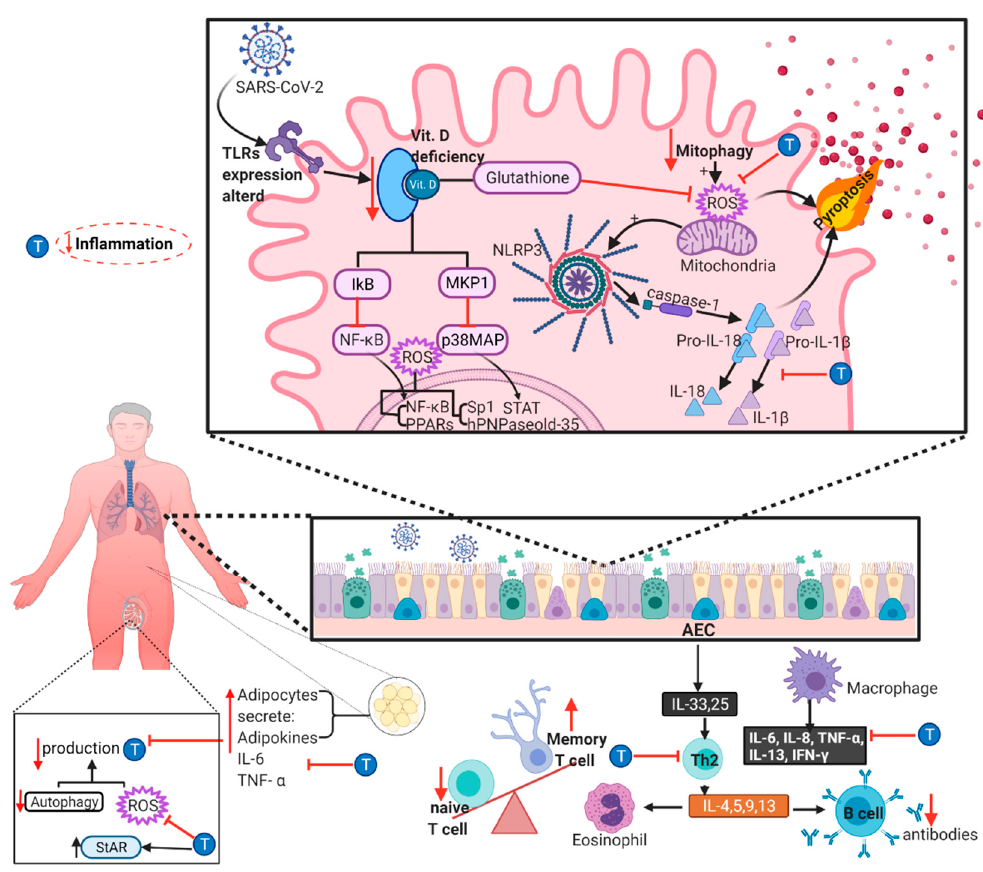
Figure 3. Testosterone mitigates the detrimental effects of inflammaging in COVID-19. Schematic representation of late-onset hypogonadism (LOH) produced by inflammaging markers, reverted with testosterone (T) supplementation, and increasing the steroidogenic acute regulatory protein (StAR) expression leading to T production. Inflammaging is characterized by alterations in autophagy and mitophagy activity, increased reactive oxygen species (ROS) production, cellular senescence, alteration of the expression of toll-like receptors (TLRs) and decrease in the concentration of vitamin D. The higher levels of ROS activate NLRP3, activating IL-1 β and IL-18 production and pyroptosis, a mechanism that the StAR could block by inducing T production. ROS also activate the transcription factors hPNPaseold-35, NF- κ B, AP-1, Sp1 and PPARs. The senescent adipocytes increase the secretion of adipokines and cytokines, such as IL-6 and TNF- α , that can also be inhibited by T. Immunosenescence can present alteration of the ratio of CD4+/CD8+ T cells, decrease immature T cells, increase memory T cells, alter Th2 response, and modify the production of pro-inflammatory cytokines. Abbreviations on the figure: T, testosterone; hPNPaseold-35, human polynucleotide phosphorylase; AP-1, activator protein 1; Sp1, specification protein 1; PPARs, peroxisomal proliferator-activated receptors; NLRP3, NOD-like receptor 3; Vit. D, vitamin D; ROS, reactive oxygen species; AEC, airway epithelial cells; StAR, steroidogenic acute regulatory protein.